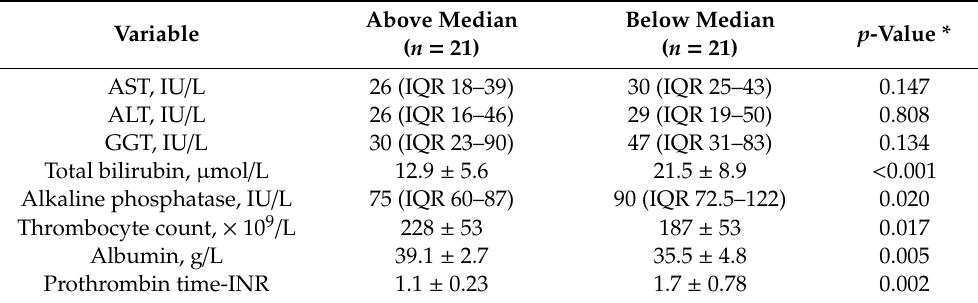
Table 2. Values of laboratory parameters reflecting hepatic function and cholestasis according to the median of measured right ventricular free wall longitudinal strain (RV